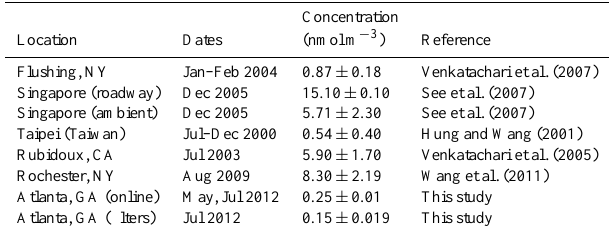
Table 4. Summary of ROS p